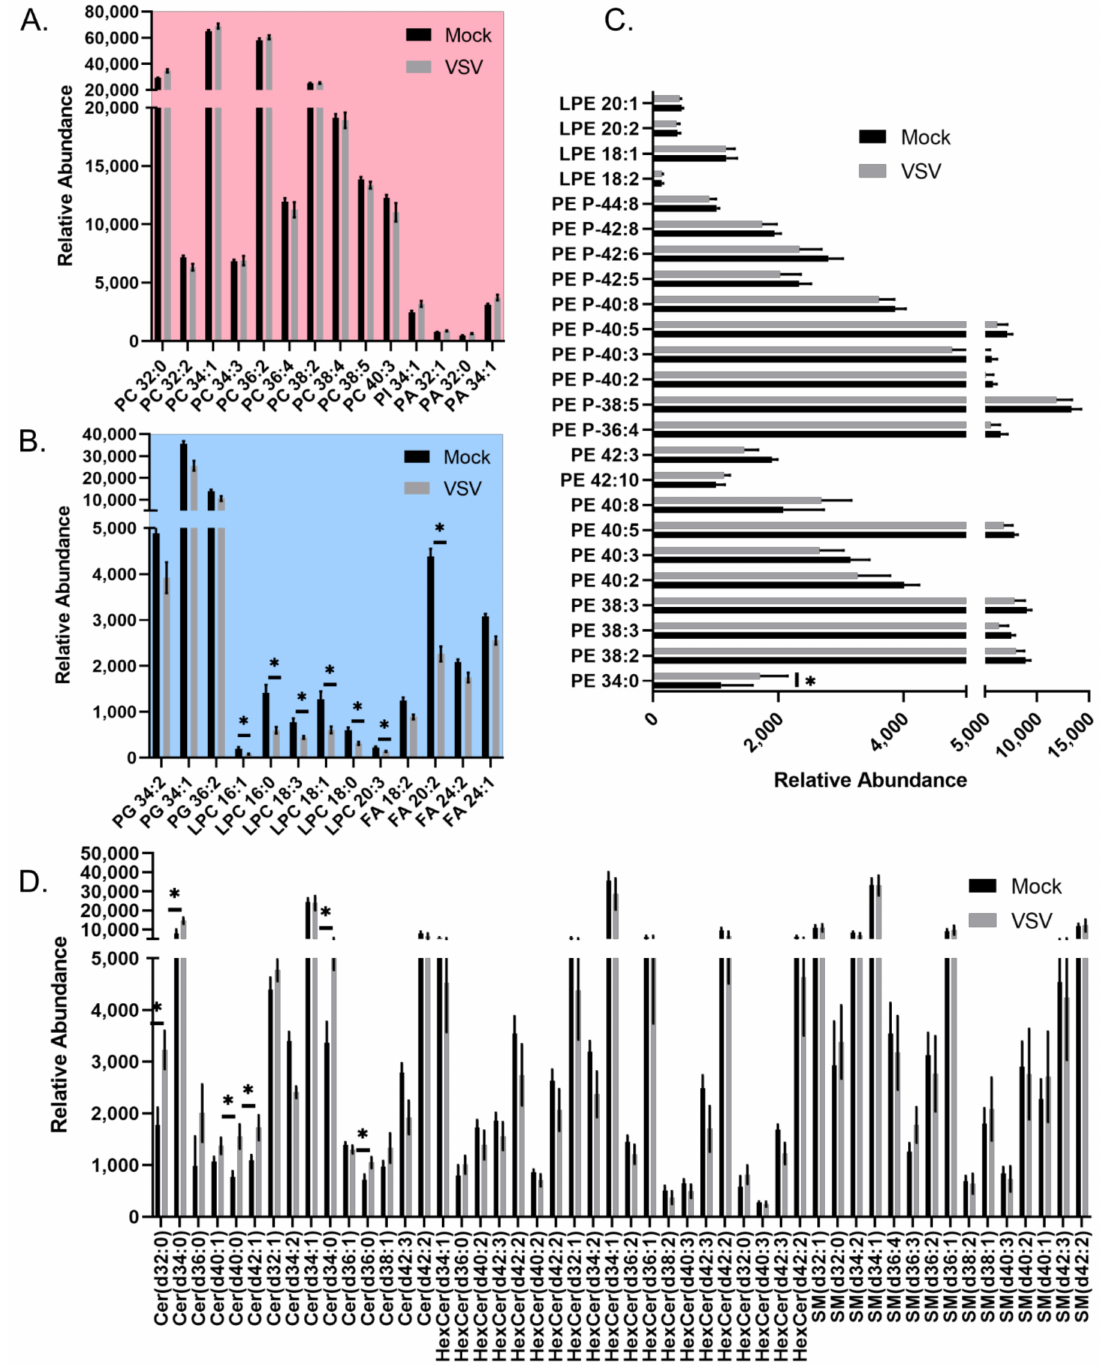
Figure 3. All lipid species identified in the positive mode data set for mock- and VSV-infected cells. Relative abundance of all identified lipids belonging to ( A ) PC, PI, PA classes, which demonstrated overall increased abundance; ( B ) Belonging to PG, LPC, FA classes, which demonstrated overall decreased abundance; ( C ) LPE and PE lipids; ( D ) Cer, HexCer, SM classes. Significantly altered lipids described in Figure 4B are denoted with an asterisk. Note, some lipids have the same sum composition (i.e., total # carbons:total # double bonds), but are not structurally identical to level of specific fatty acyl tails and positions. Lipids that are included multiple times appeared at different retention times or had unique m / z values due the formation of different